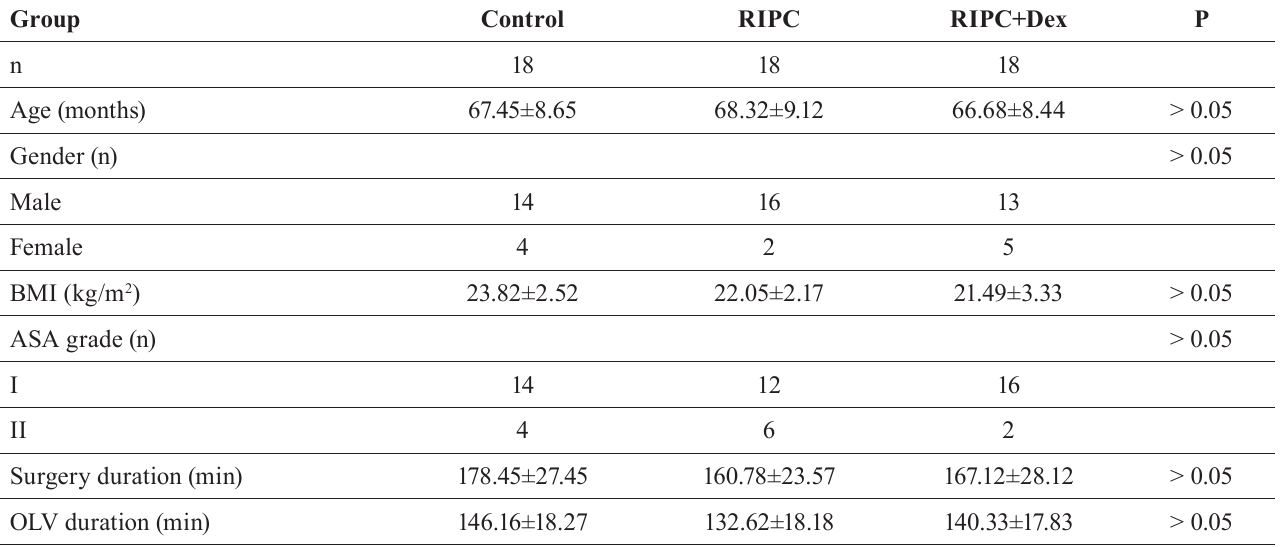
TABLE I - G eneral information of patients in three groups Group Control RIPC